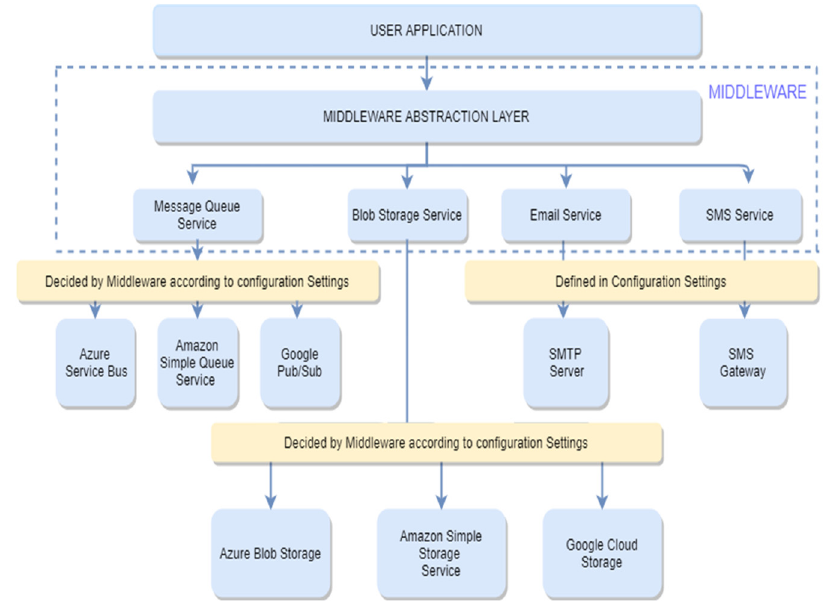
Figure 1. Architecture diagram of the proposed middleware.